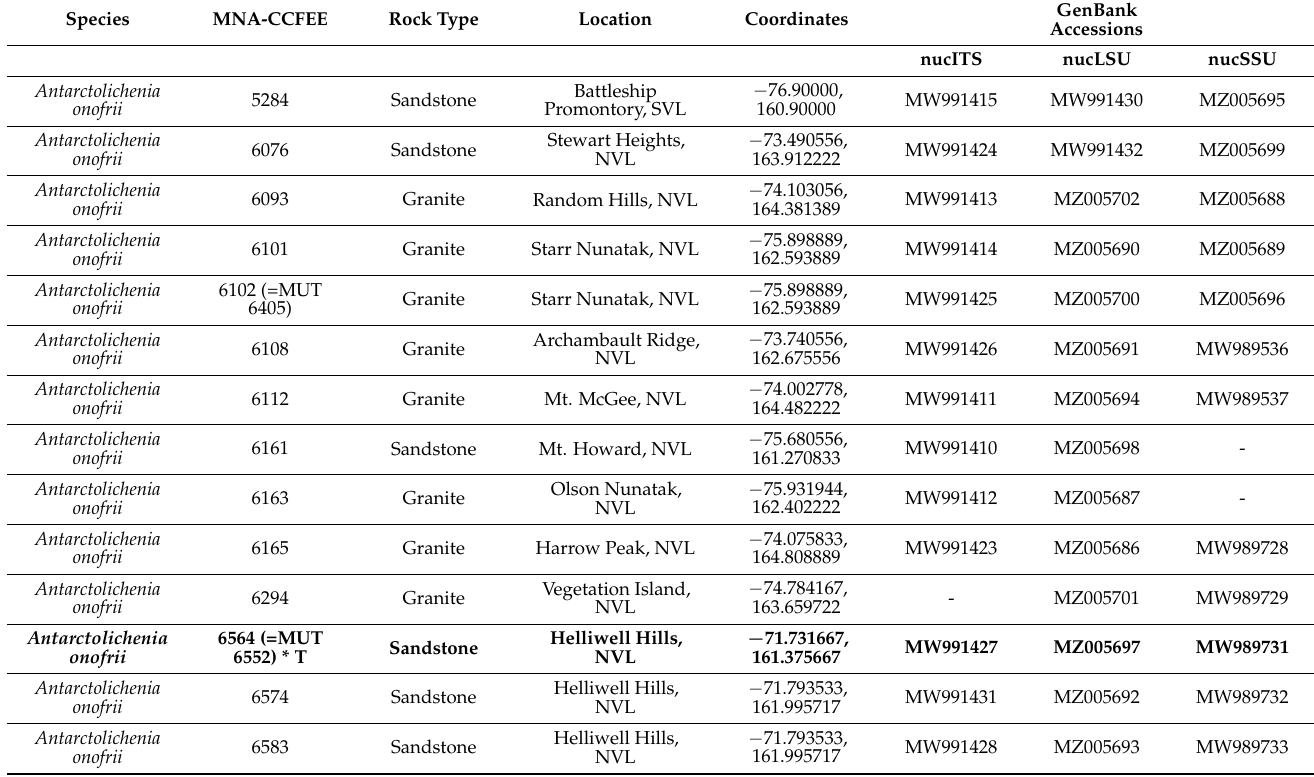
Figure 1. ( A ) Map of Victoria Land in continental Antarctica and the localities from where Antarctolichenia onofrii strains have been isolated; ( B , C ) a typical environment characterizing the sampling localities: the Archambault Ridge ( B ) and Random Hills ( C ); and ( D ) the rock colonized by cryptoendolithic communities on Mt. Howard. Table 1. Details of the geographic origin and NCBI accession numbers of Antarctolichenia onofrii analyzed in this study. The type strain is highlighted in bold. SVL = southern Victoria Land and NVL = northern Victoria Land. * T = type